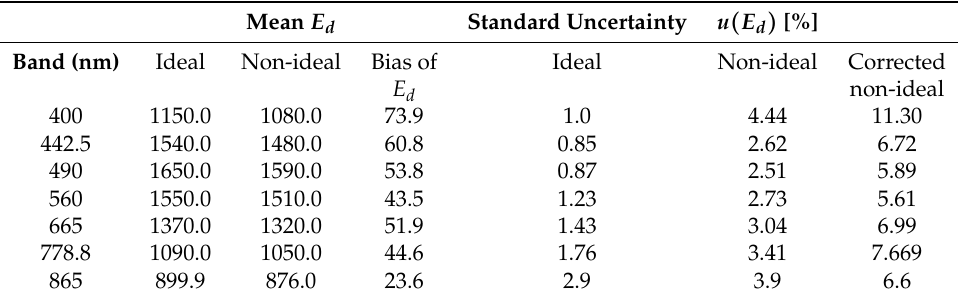
Table 4. The mean and standard uncertainty as a percentage of the mean of the downwelling irradiance, E d [ mWm − 2 nm − 1 ] presented for the ideal and non-ideal cases. Mean E d Standard Uncertainty u ( E d ) [%]